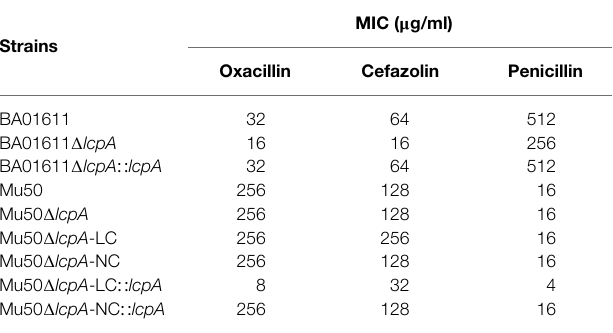
LC, large colony; NC, normal